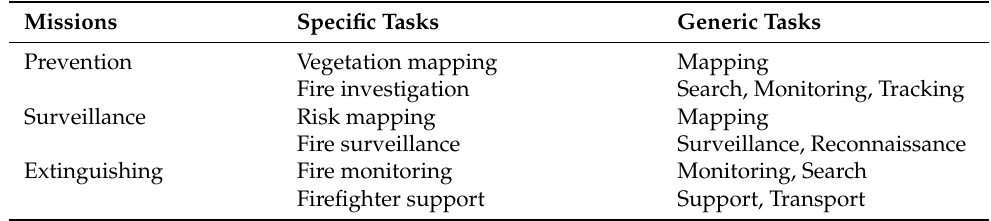
Table 1. List of tasks considered for firefighting